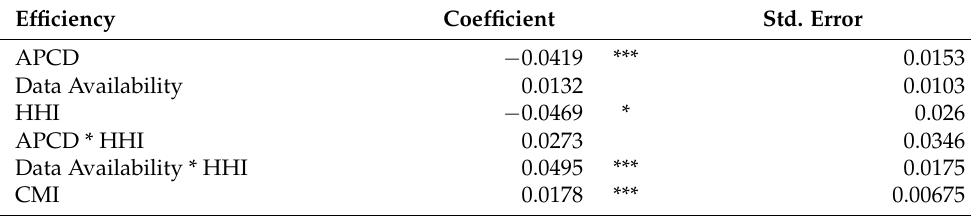
Table 5. Cross-sectional Time-Series Tobit Analysis Results ( N =